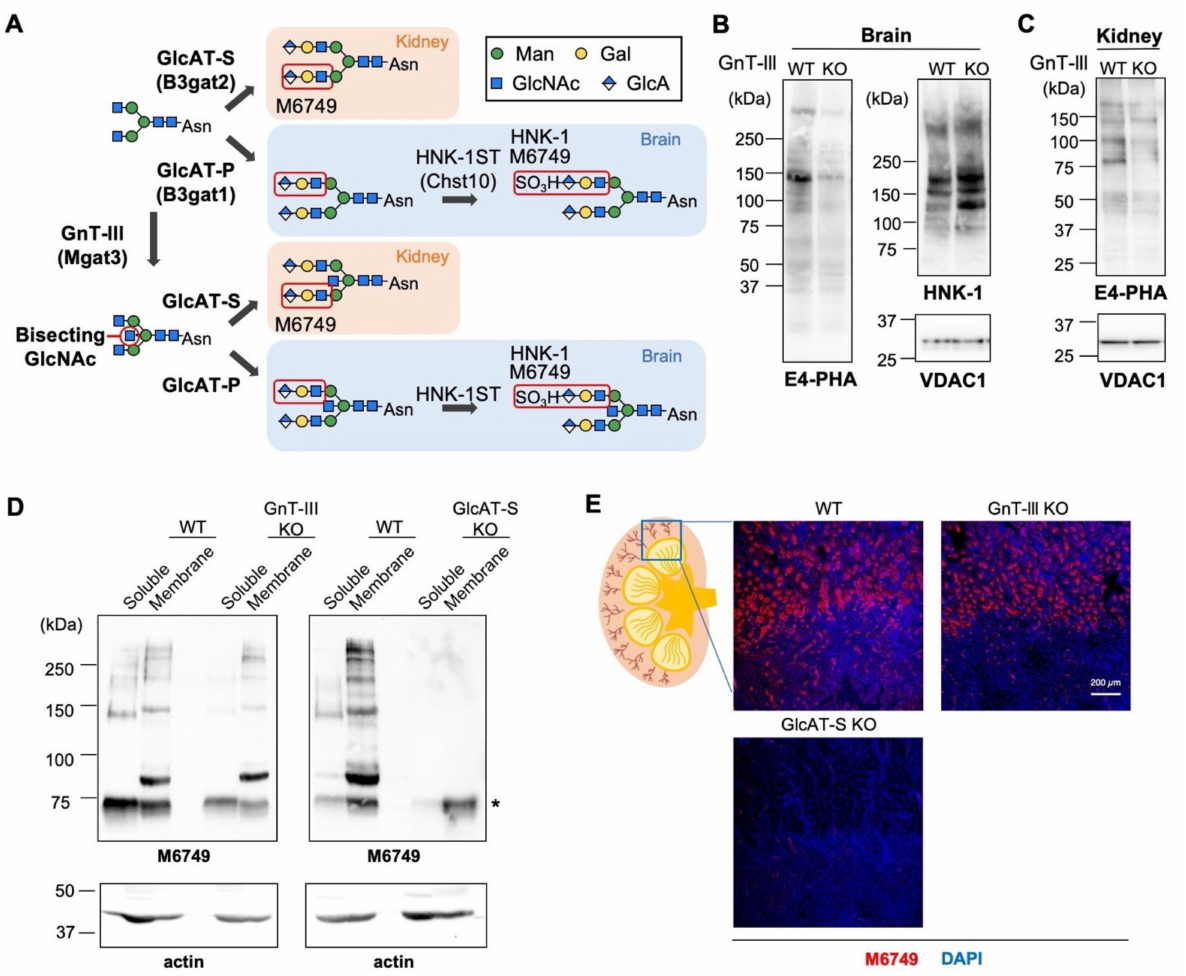
Figure 1. Unaltered expression of non-sulfated HNK-1 glycan in GnT-III KO mouse kidney. ( A ) Schematic diagram of HNK-1 biosynthesis. GnT-III catalyzes the addition of bisecting GlcNAc in N -glycan. GlcAT-P transfers GlcA, and HNK-1ST subsequently sulfates GlcA to produce HNK-1 epitope. In mouse kidney, GlcAT-S is expressed and synthesizes non-sulfated HNK-1 epitope that is recognized by M6749 mAb. ( B ) Proteins in brain membranes from adult WT or GnT-III KO mice were blotted with E4-PHA lectin, HNK-1 mAb, and anti-VDAC1 Ab. ( C ) Proteins in kidney membranes from adult WT or GnT-III KO mice were blotted with E4-PHA lectin and anti-VDAC1 Ab. ( D ) Soluble and membrane proteins from adult WT, GnT-III KO, or GlcAT-S KO mouse kidneys were blotted with M6749 mAb and anti-actin Ab. The asterisk indicates mouse IgM that is reactive to the secondary antibody. ( E ) Sections from WT, GnT-III KO, or GlcAT-S KO mouse kidney were immunostained with M6749 mAb and DAPI. Bar: 200 µ